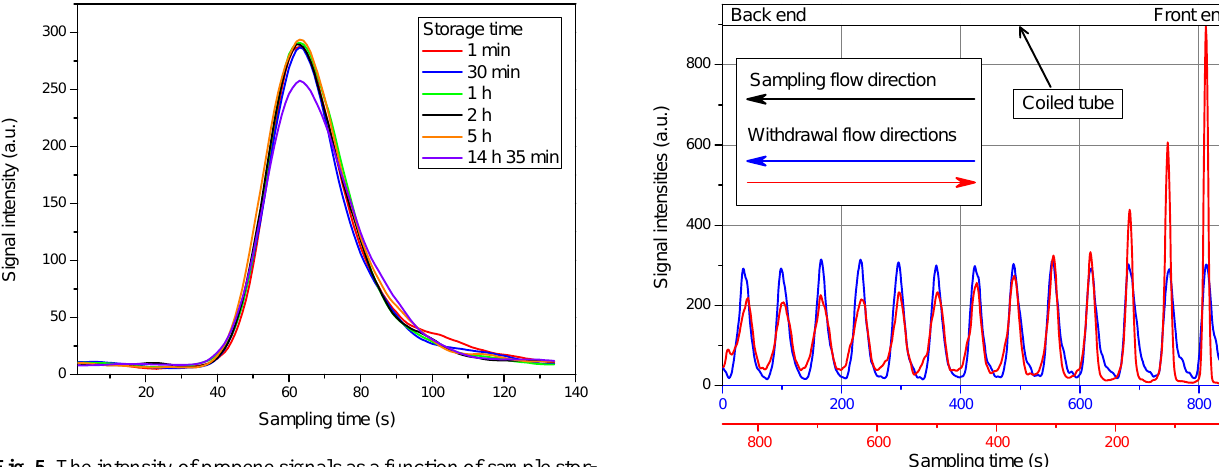
Fig. 5. The intensity of propene signals as a function of sample stor- age time. Each propene injection lasted for 0.2s, the time interval between two injections was set to 19.8s.